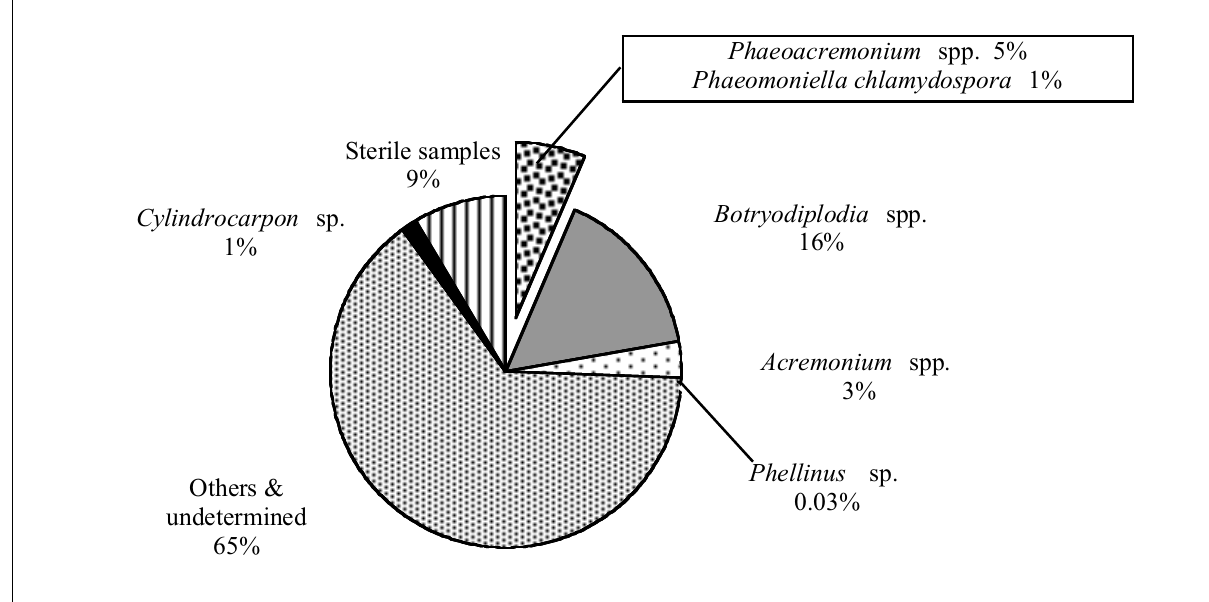
Fig. 2. Percentage of Phaeoacremonium species and Phaeomoniella chlamydospora out of the total microflora isolat- ed from young vines showing decline symptoms.